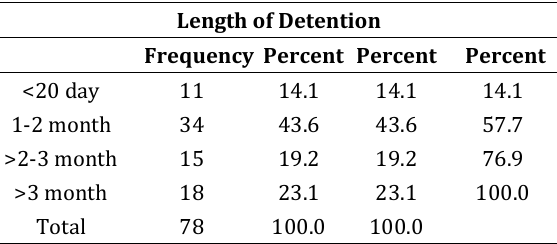
Table 3. Distribution of Respondents by Length of Detention in Penitentiary Class II A Kediri